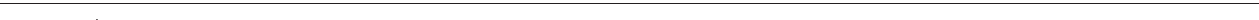
FIGURE 2 | performed no Exergaming agility exercise program and no Exergaming agility exercise Maintenance program. (A) Observed scores, such as baseline. (B) The longitudinal linear mixed effects modeling of M-EDL fitted with maximum likelihood estimation, adjusted for the baseline and 16 covariates. (C) The combined longitudinal linear mixed effects modeling with the semiparametric Cox regression to model survival. Time course trajectories based on the observed data (A) and the longitudinal linear mixed effects modeling (B) were robust so that adjusting the observed data for missing data ( n = 3 per group starting at 24 months), deaths ( n = 1, n = 5, and n = 9 in E + M, E, and C, respectively), the baseline differences, and covariates did not affect the treatment effects (C) . The vertical bars denote ± 1 SD in (A) and 95% CI in (B,C)